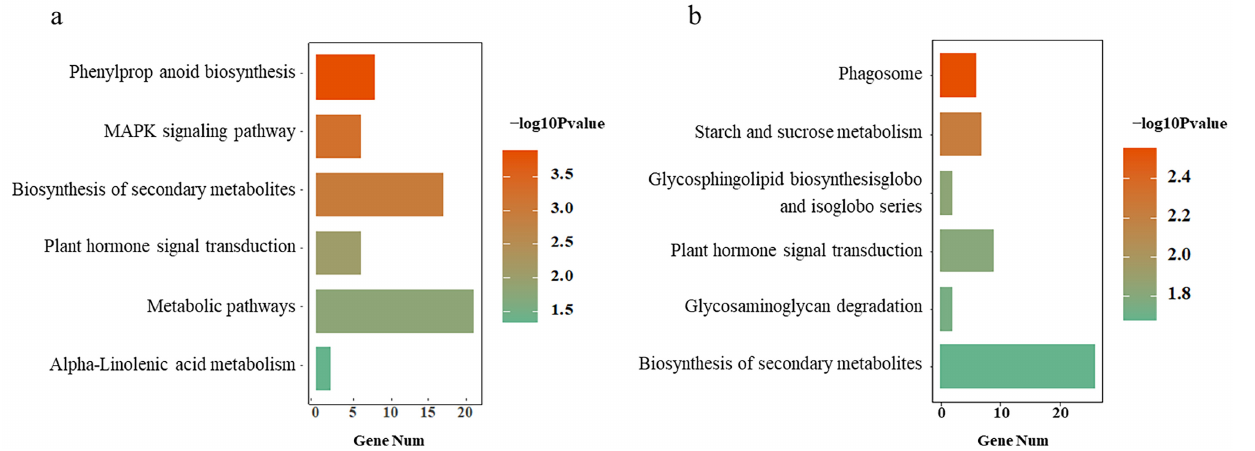
Figure 5. Functional annotation of consistent DEGs in the three rice varieties. KEGG pathway analysis of 235 up-regulated genes ( a ) and 689 down-regulated genes ( b ). The x-axis represents the number of genes in each pathway, and the y-axis shows the top six enriched KEGG pathways. Colors in the bar plots indicate statistical significance in log format.